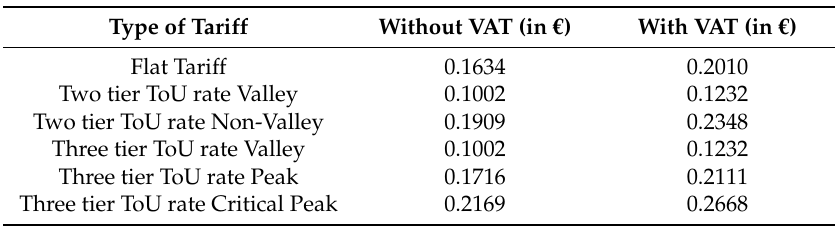
Table 1. The prices of the electricity tariffs in € /kWh.